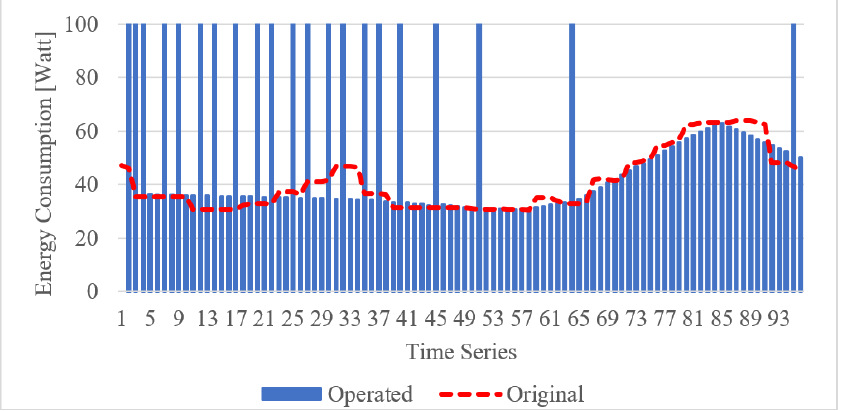
Figure 18. Energy consumption comparison of intelligent heater operation and original user data.